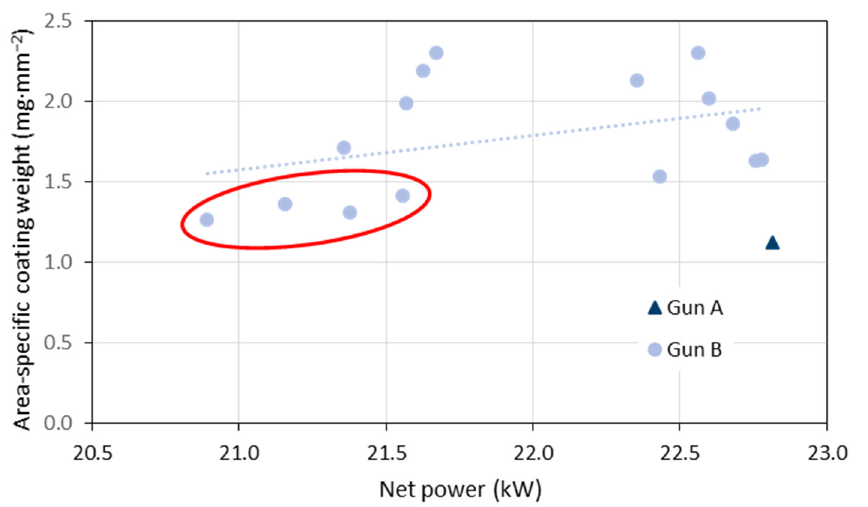
Figure 6. Area-specific coating weights plotted against the torch net power.